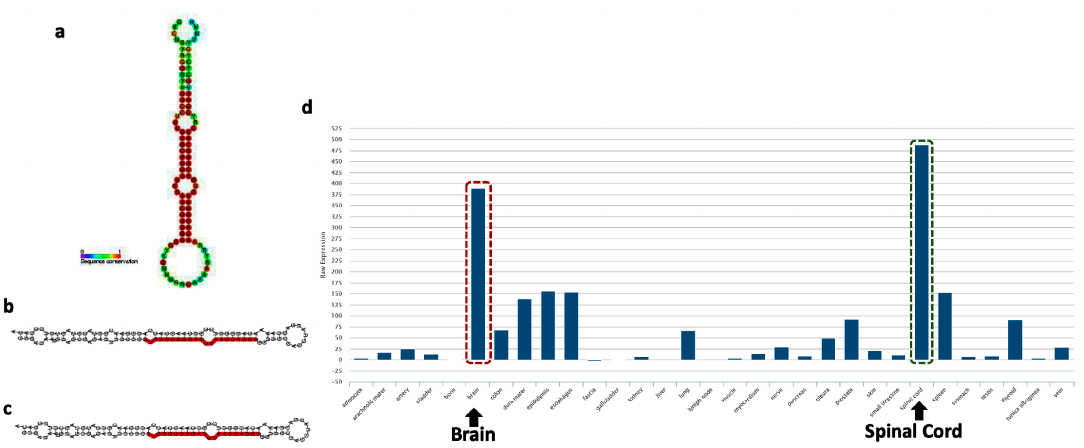
Figure 2. MiR-218 characteristics. Stem-loop structure of precursor miR-218 ( a ). The color scale shows the sequence conservation pattern within the stem-loop structure of the precursor miR-218. The independent stem-loop structure of miR-218-1 ( b ) and miR-218-2 ( c ). The expression atlas of mature miR-218-5p in different human tissue types. The highlighted bar shows the highest expression level observed in brain tissue besides the spinal cord ( d